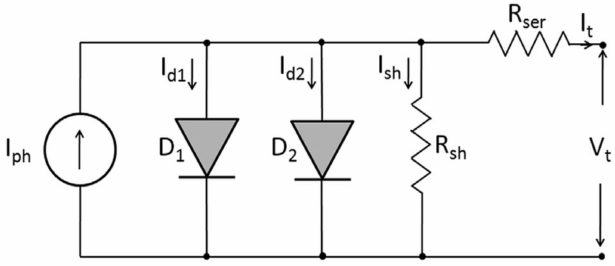
Figure 4. A two-diode model of photovoltaic